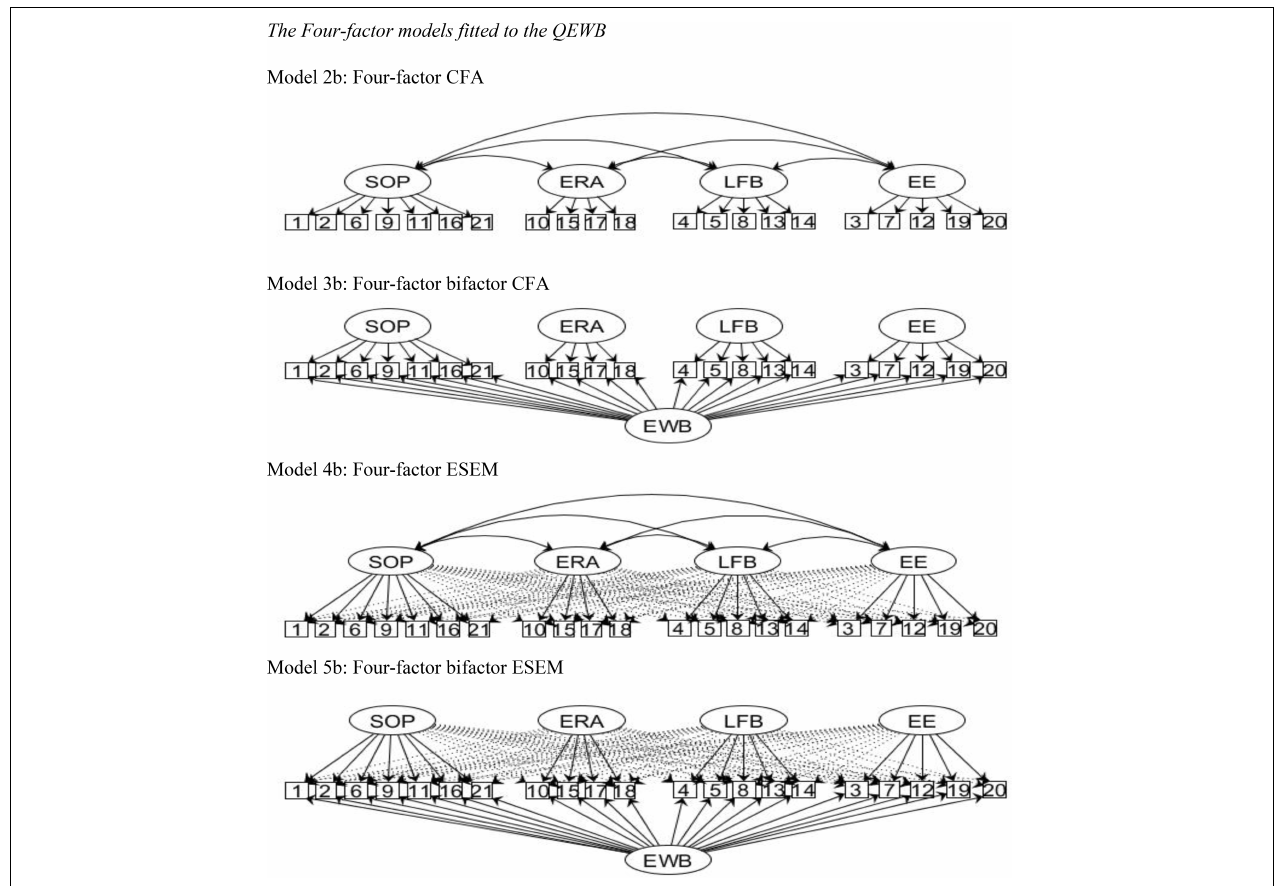
FIGURE 2 | The four-factor models fitted to the QEWB. Model 2b: Four-factor CFA. Model 3b: Four-factor bifactor CFA. Model 4b: Four-factor ESEM. Model 5b: Four-factor bifactor ESEM. EWB, Eudaimonic Well-being; SOP, Sense of Purpose factor; ERA, Engagement in Rewarding Activities; LFB, Living from Beliefs; EE, Effortful Engagement